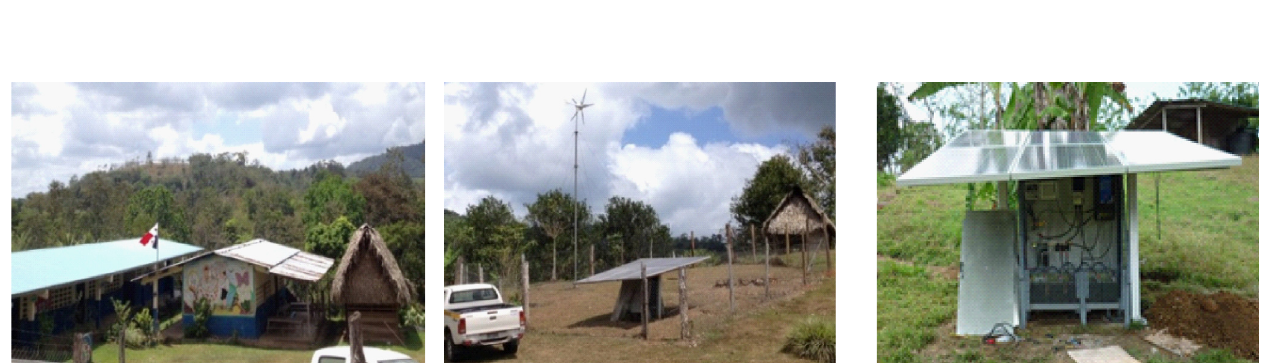
Fig. 1. Boca de Lura school facilities and power plant views.